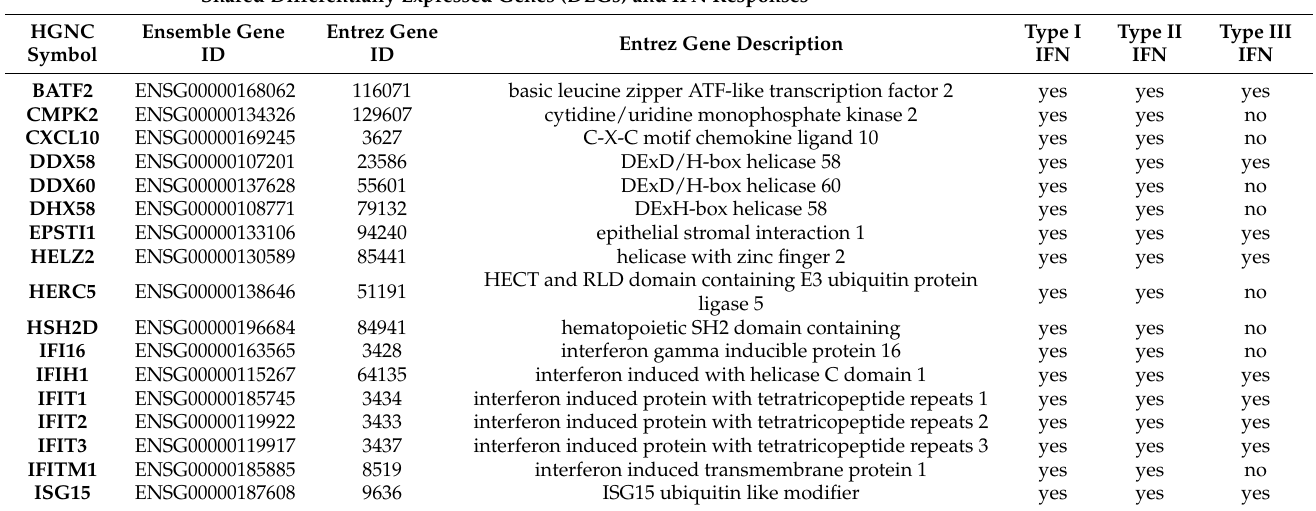
Figure 4. Shared differentially expressed genes (DEGs) across datasets, which are part of the conserved epithelial response to viral infection, are enriched in IFN-associated genes . Shared and unique DEGs across all datasets were determined using the package DESeq2 and heatmaps generated with the package ComplexHeatmap in R. For a gene to be classified as differentially expressed it had to meet the criteria of an actual fold-change of at least 1.5 (Log 2 FC > 0.58) with a false discovery rate (FDR) cutoff of 1% (adjusted p -value < 0.01) using an Empirical Bayes (EB) approach with the R package ashr. The intersection and union of DEGs across the three RNA-seq datasets evaluated is shown ( A ). Expression pattern for DEGs shared across all datasets is shown, with genes annotated in the Entrez Molecular Sequence Database System as part of IFN responses highlighted in red and genes with a symbol containing IFI (IFN-inducible) or ISG (IFN-stimulated genes) in orange ( B ) . Partially shared DEGs in two out of three RNA-seq datasets are also shown ( C ). The sampling time point in hours post-infection (h.p.i) at which each RNA-seq dataset was generated is indicated. Table 2. Differentially expressed genes (DEGs) shared in all datasets that are linked to IFN responses. This list contains DEGs that were identified in each dataset and thus thought to contribute to the conserved antiviral response of human intestinal enteroids (HIEs) as well as their association with Type I, II and III IFN responses according to the Interferome database. Shared Differentially Expressed Genes (DEGs) and IFN